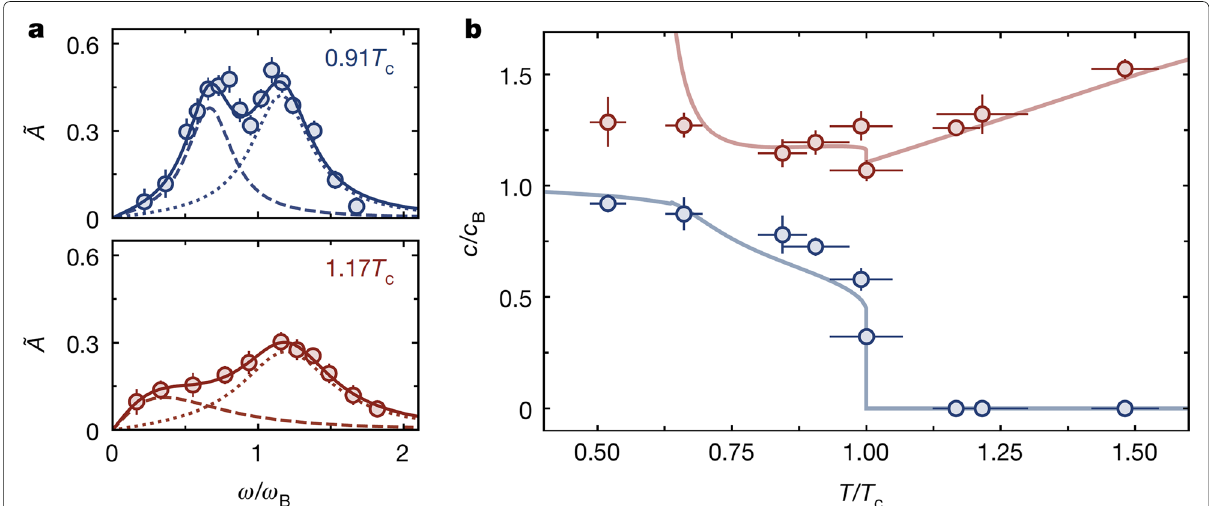
Fig. 17 a Normalized density response spectra ˜ A (ω) at 0.91 T c and 1.17 T c . Below T c (top), two resonances corresponding to the first (dotted) and second (dashed) sound are observed. Above T c (bottom), the first-sound resonance (dotted) exists, but the second sound is replaced by a diffusive, overdamped mode (dashed). b Normalized sound velocities, c 1 / c B (red) and c 2 / c B (blue), and the corresponding theoretical predictions for infinite-systems without any free parameters. The discontinuities in predicted velocities at T c are due to the jump in superfluid density across the BKT transition. Adapted from Ref.